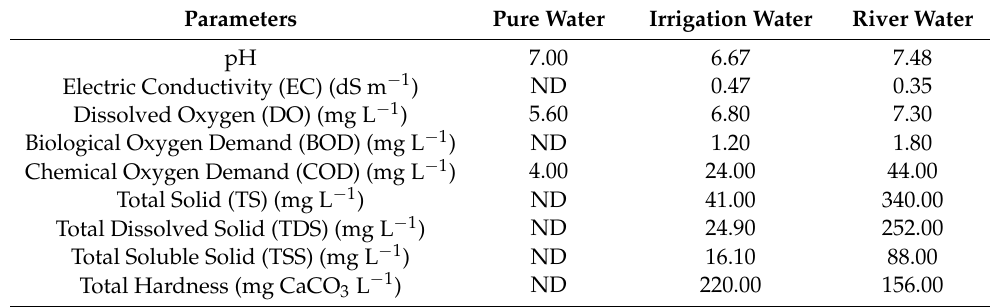
Table 1. Water quality